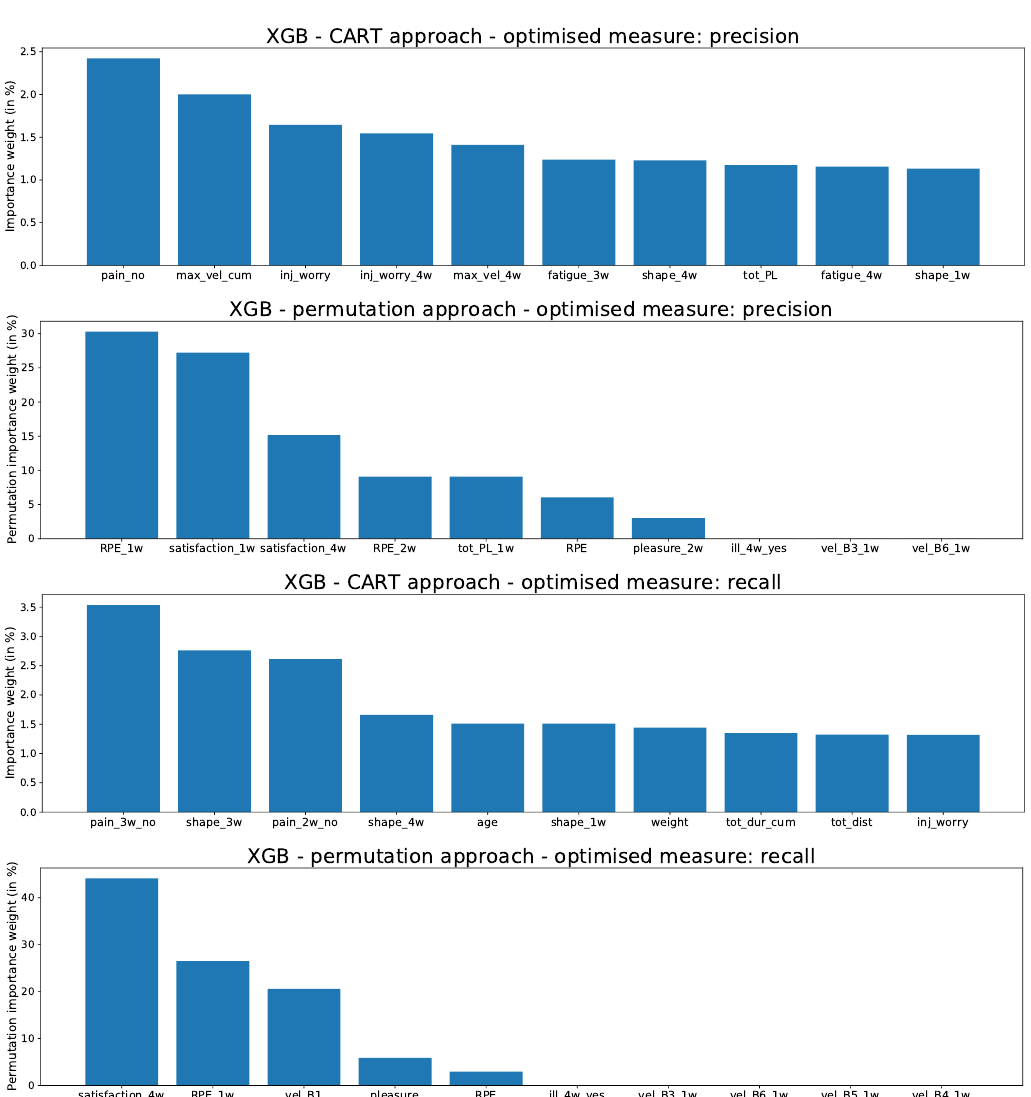
Figure 8. Best features importance for 1-month injury